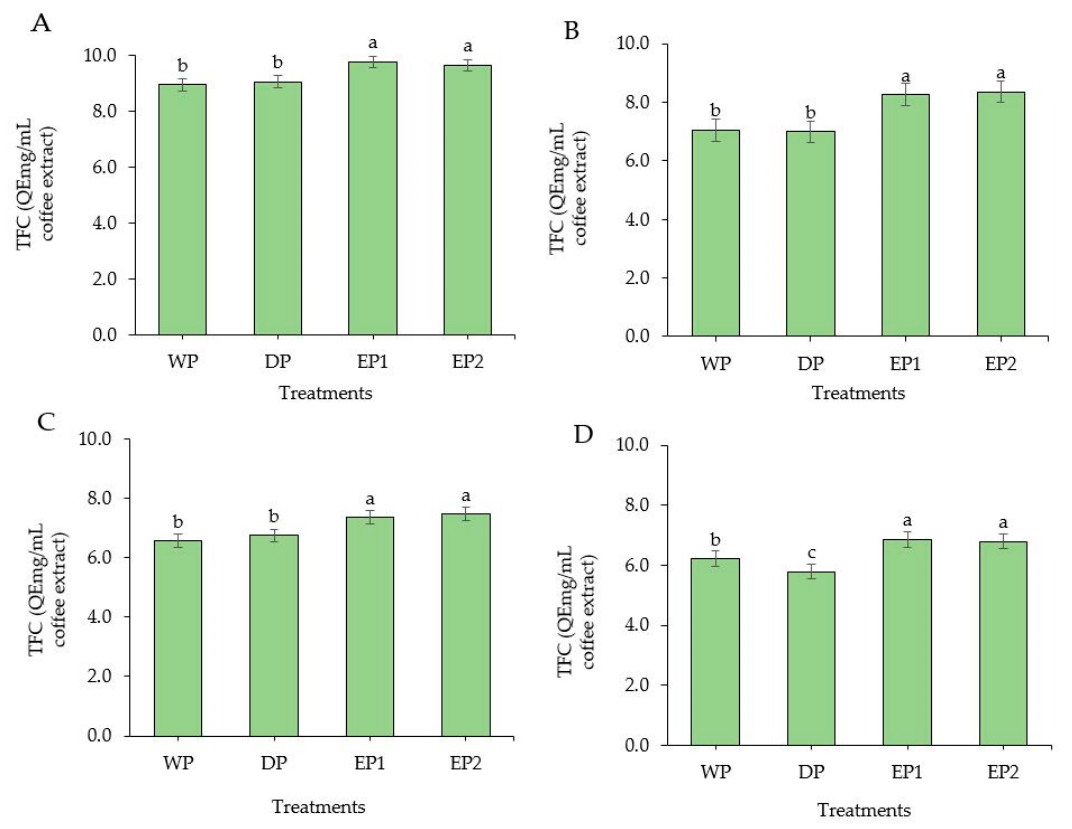
Figure 5. Total flavonoid content of green and roasted coffee beans that processed with different methods. (( A ): Green beans; ( B ): Light roasted, ( C ): Medium roasted; ( D ): Dark roasted). EP1: elephant dung coffee (pulp was completely digested); EP2: elephant dung coffee (pulp was not digested); WP: wet-processed beans; DP: dry-processed beans. Different letters above the bars indicate statistically significant difference at p < 0.05.